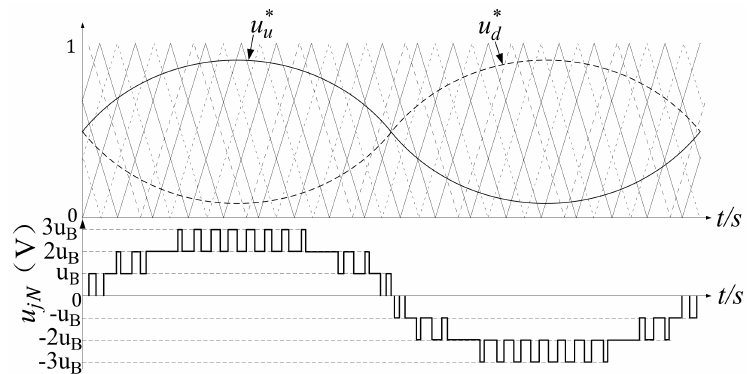
Figure 2. A diagram of the carrier phase-shift modulation (7